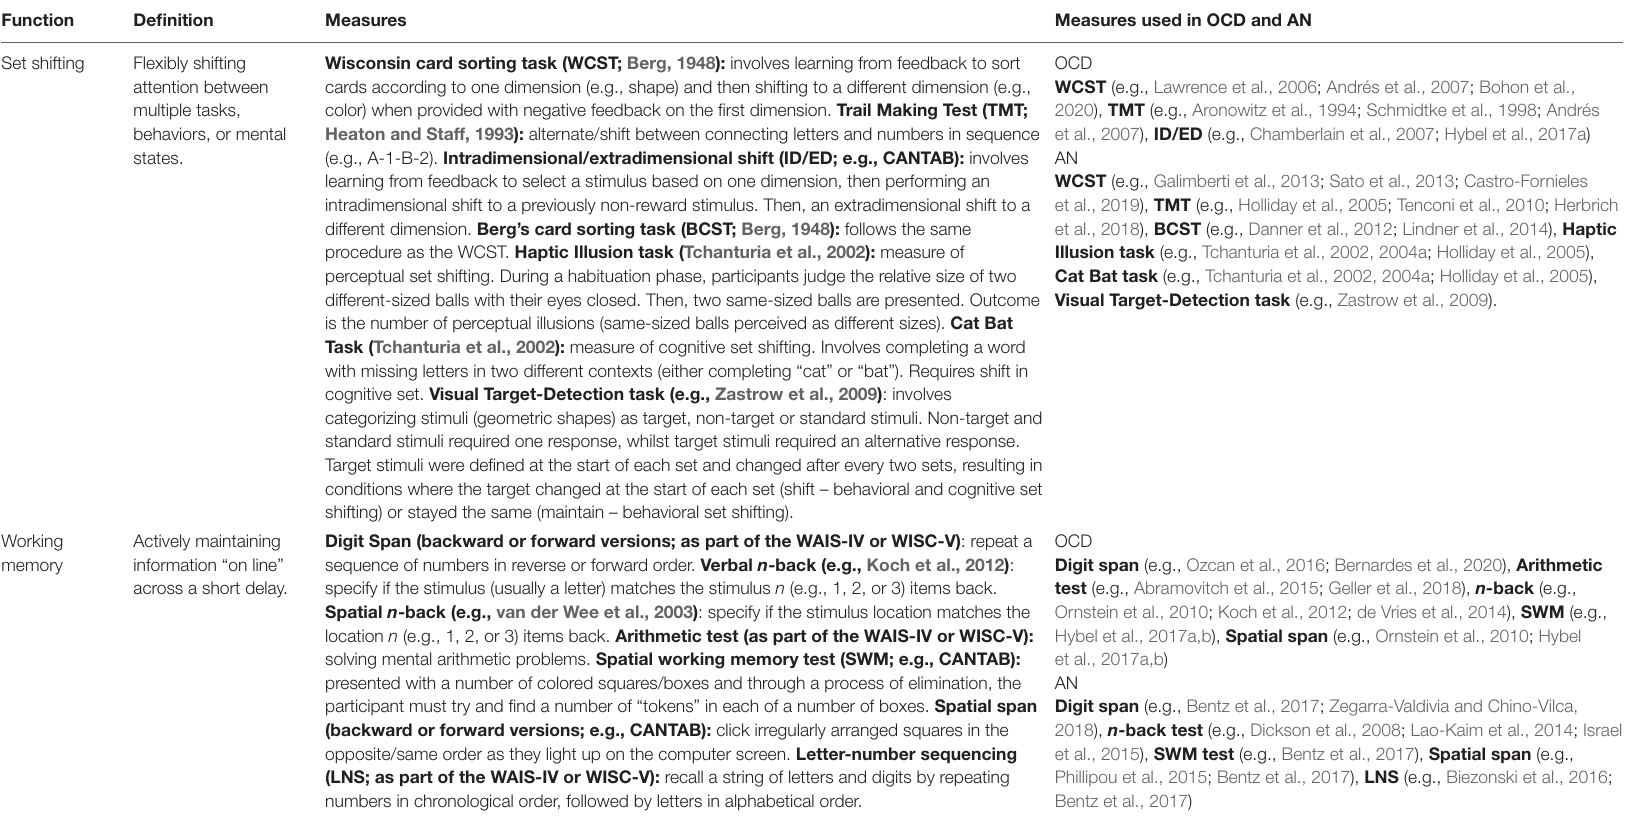
TABLE 1 | Executive function processes and measures in Obsessive–Compulsive Disorder (OCD) and Anorexia Nervosa (AN) samples. Function Definition Measures Measures used in OCD and